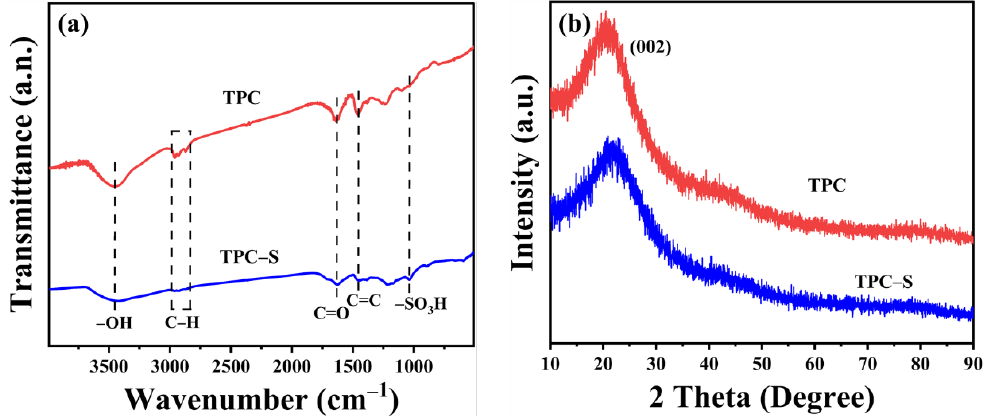
Figure 1. ( a ) FT-IR spectra and ( b ) XRD diffraction patterns of TPC and TPC – S. Table 1. The distance between carbon layers of TPC and TPC – S.